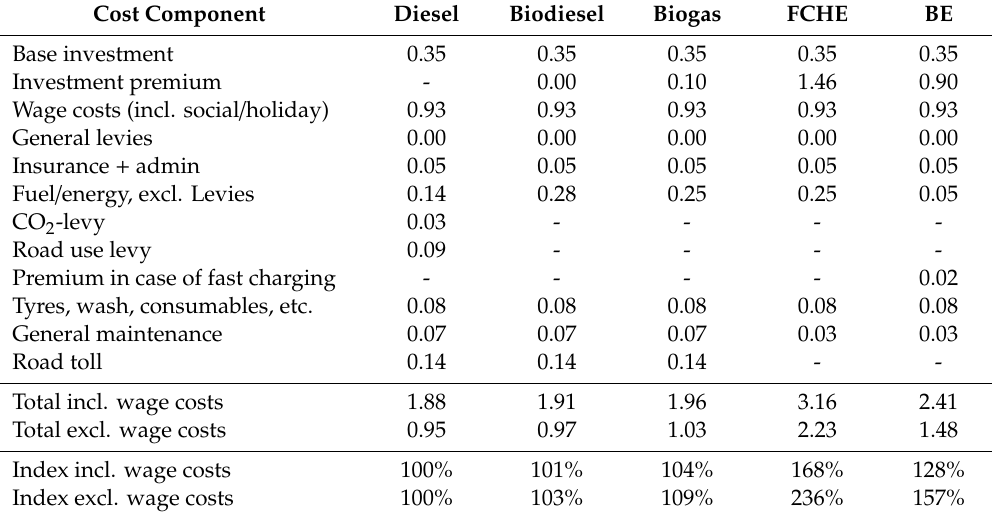
Table 4. Decomposed ownership costs for light distribution trucks. Base scenario / early stage. Figures in EUR / km. Costs are based on a period of analysis of 5 years and annual mileages of 45,000 km.